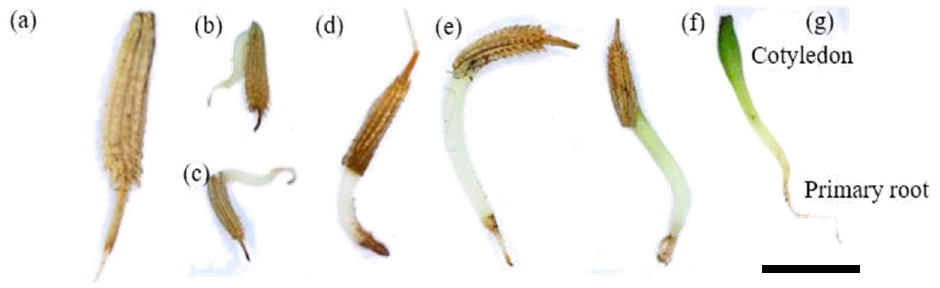
Figure 3. Seedling development of Taraxacum officinale seeds in 2.3% SUC and 0.225 mg/L NAA-3.0 mg/L BAP at ( a ) 0, ( b ) 5, ( c ) 6, ( d ) 7, ( e ) 10, ( f ) 14 and ( g ) 21 days after sowing (18/6 h light/dark, 18 ±2 °C). The size of the bars is 5 mm.